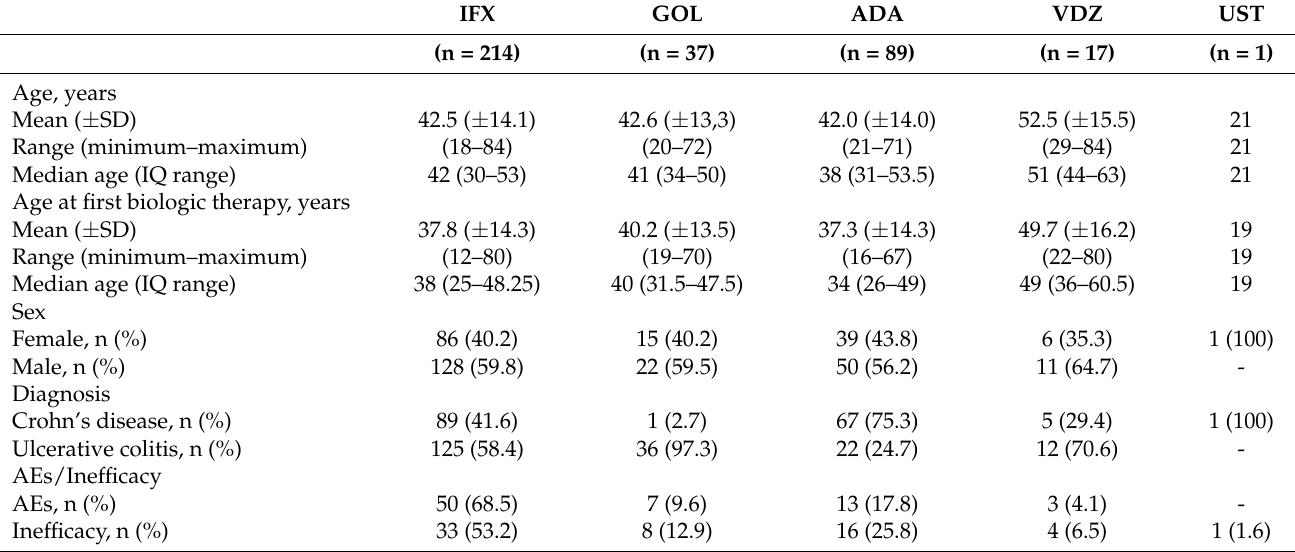
Table 2. Characteristics of the study cohort per drugs in first-line biologic therapy.